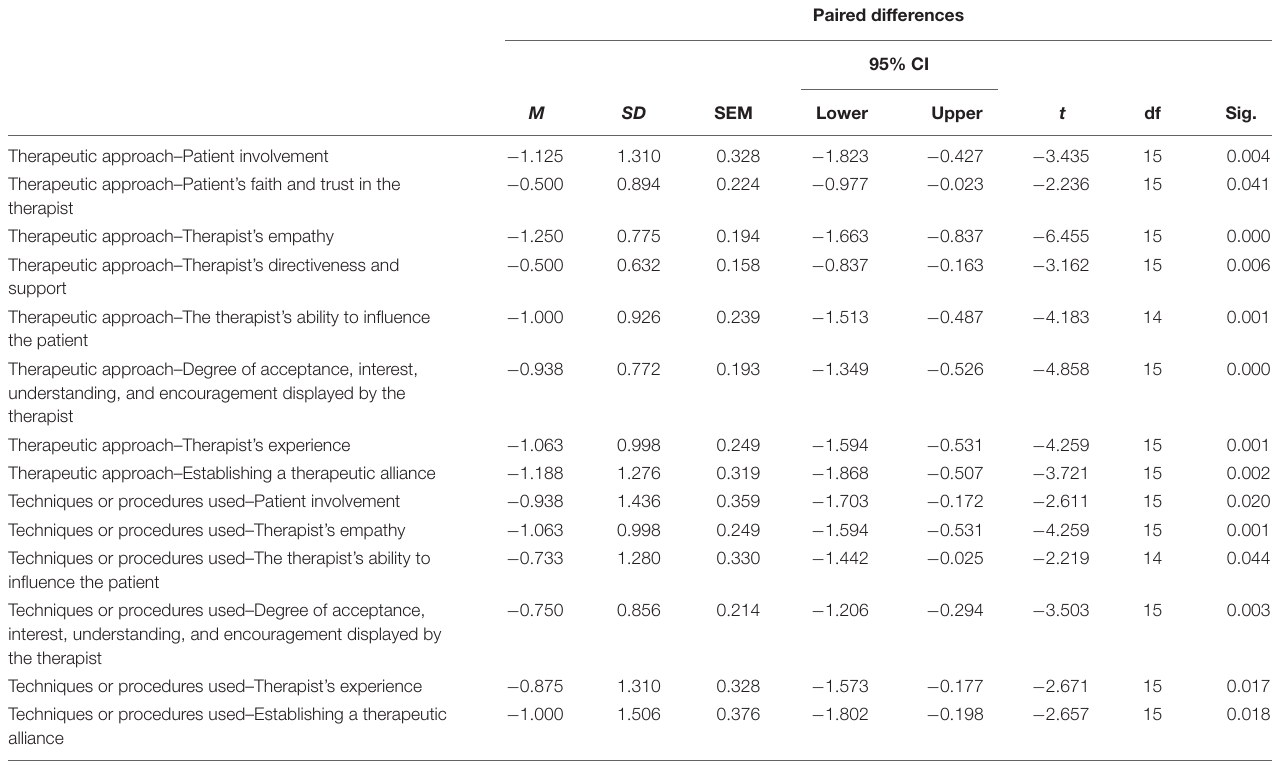
TABLE 5 | Paired samples t -test between the variables “Therapeutic approach” and “Techniques and procedures used” and the rest of the common variables in therapists who considered different psychotherapeutic models to have similar effectiveness.